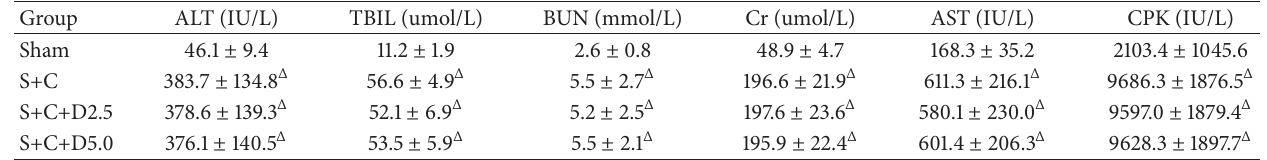
Table 1: Effects of DEX administration in liver, kidney functions during postpartum BMODS in rats.